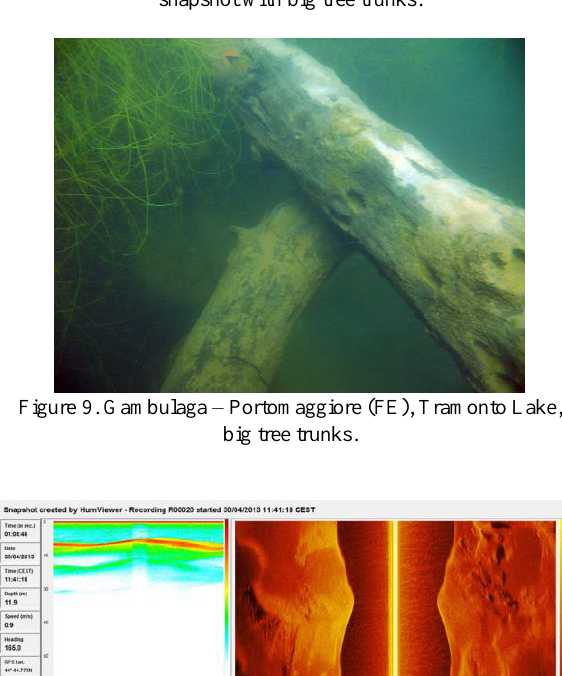
Figure 6. Gambulaga – Portomaggiore (FE), Tramonto Lake. 3D Plan view (G. Zuffi).